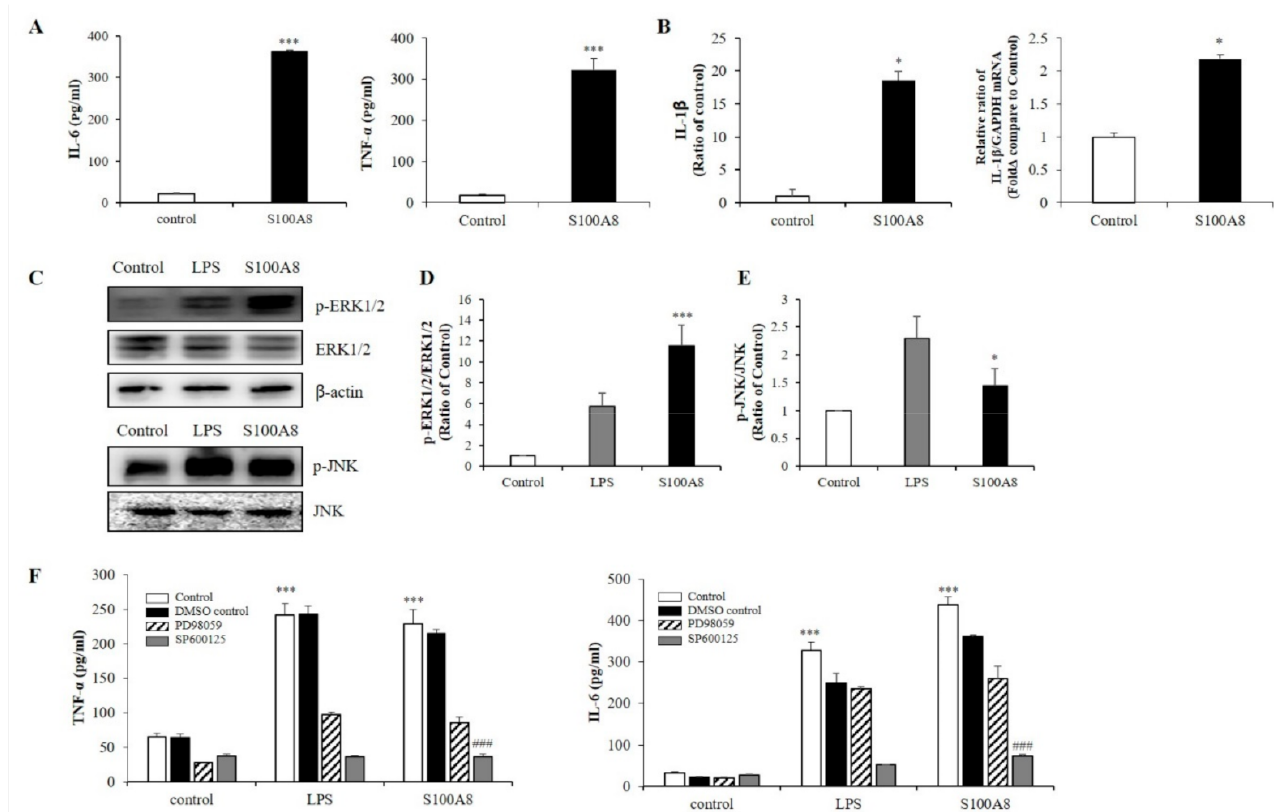
Figure 2. S100A8 induces pro-inflammatory cytokines and inflammation in BV-2 cells. BV-2 cells were stimulated with S100A8 (10 µ g/mL) for 24 h. ( A ) The supernatant was collected and TNF- α and interleukin-6 (IL-6) analyzed by ELISA. ( B ) The protein and mRNA were extracted, and the expression levels of IL-1 β were assessed by ELISA and RT-qPCR. ( C – E ) The protein was extracted, separated on 10% SDS-acrylamide gels (15 µ g/lane) and transferred to nitrocellulose membrane. The protein expression level was detected by western blotting with anti-ERK1/2, anti-phospho-ERK1/2 (p-ERK1/2), anti-JNK and anti-p-JNK. ( F ) Cells were pre-treated with ERK inhibitor (PD98059, 20 µ M), JNK inhibitor (SP600125, 10 µ M) or the equivalent volume of DMSO for 1 h, then stimulated for 24 h with LPS or S100A8 for ELISA of TNF- α , IL-6. Data from three independent experiments are presented as the means ± S.D. Values of * p < 0.05, *** p < 0.001 versus control; ### p < 0.001 versus S100A8-treated sample were considered as statistically